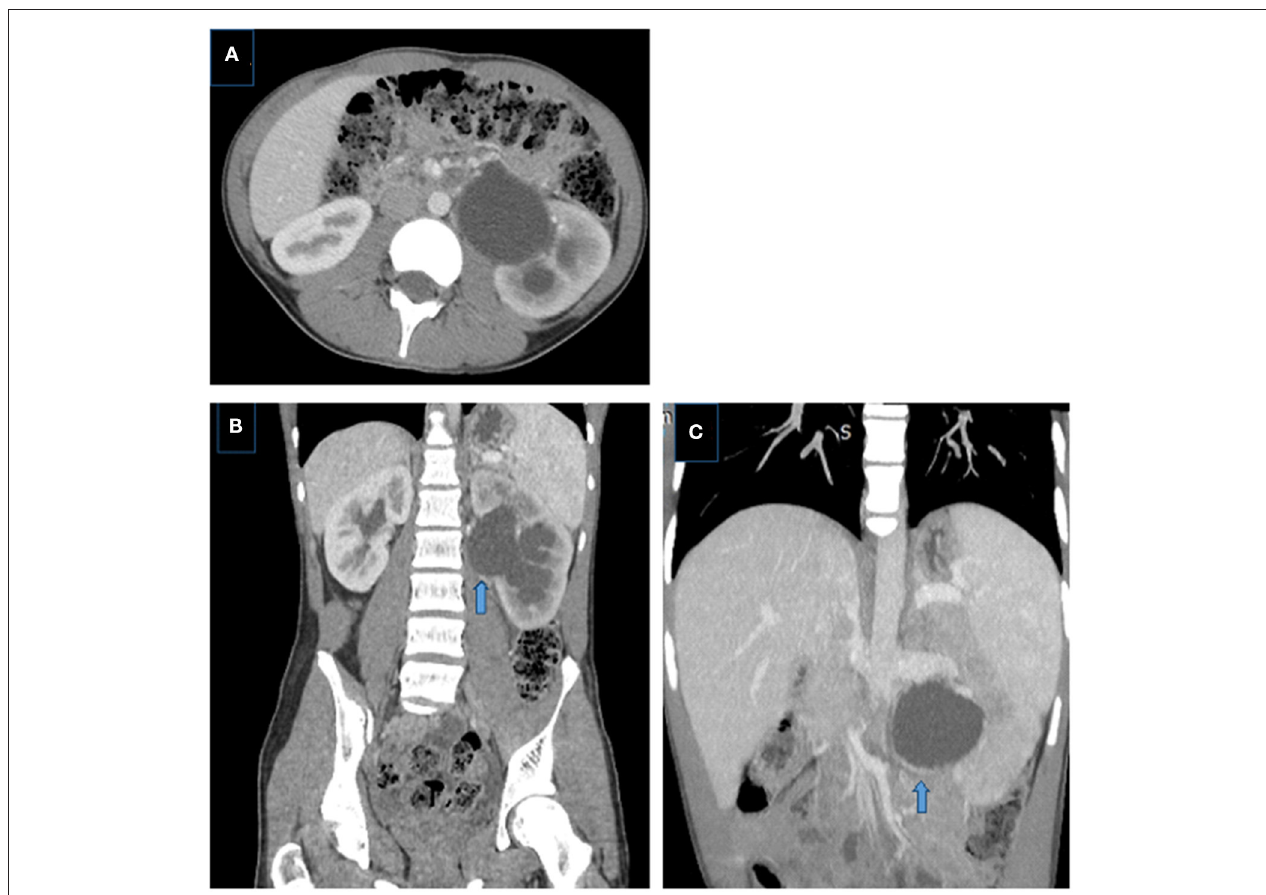
FIGURE 8 | Crossing aberrant renal artery causing left UPJ obstruction in a 14 year-old boy. (A) Axial and (B) coronal CT images showing left pelvicalyceal system dilatation with delayed nephrogram phase, pelvis is extrarenally located, dilatation is more prominent in the pelvis than calices, note the crossing vessel (arrow). (C) Coronal MIP image better demonstrates the crossing vessel as the cause of UPJ obstruction (aberrant lower pole artery)